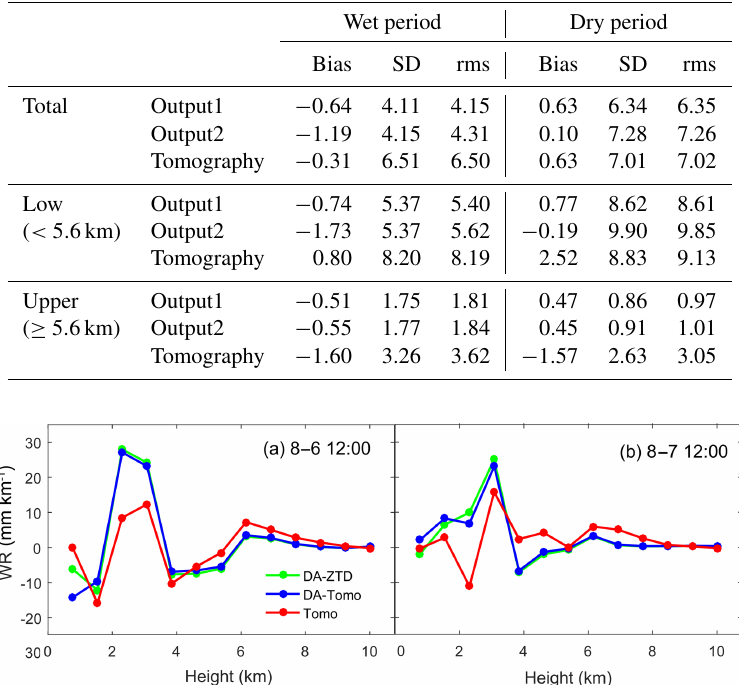
Figure 7. Differences between WR obtained by various methods and radiosonde